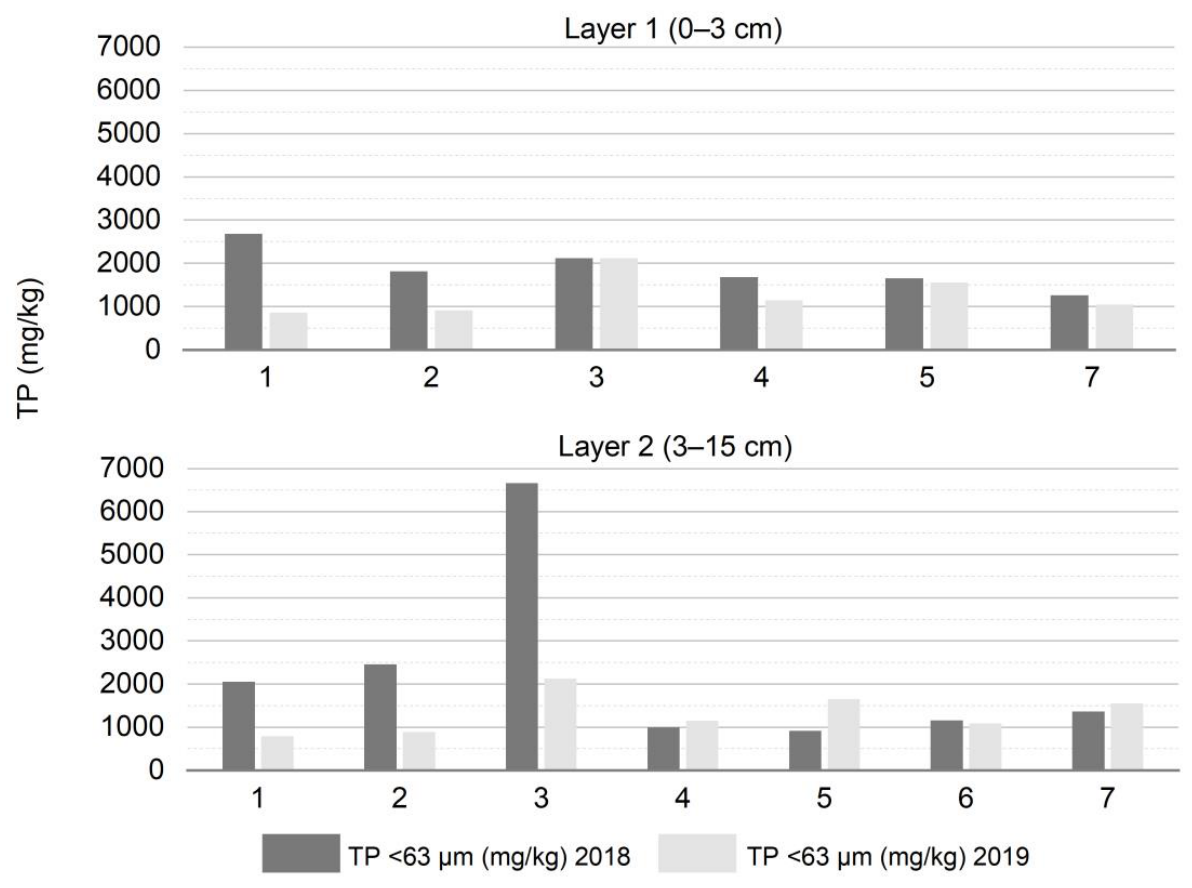
Figure 9. TP concentration (mg/kg) in the river sediment.